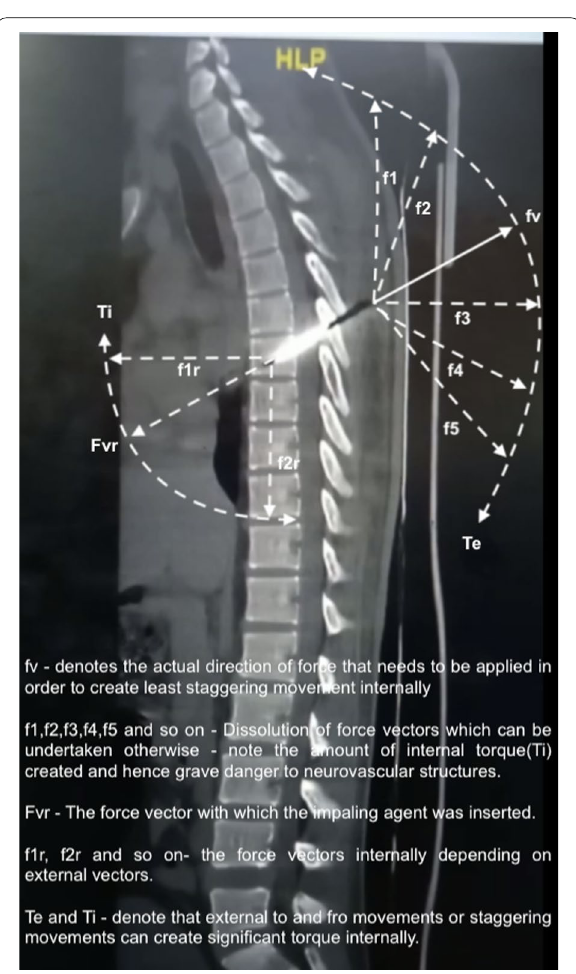
Fig. 3 Illustrates the force and force vectors along with internal and external torque generated while trying to manipulate the impaling agent out of the